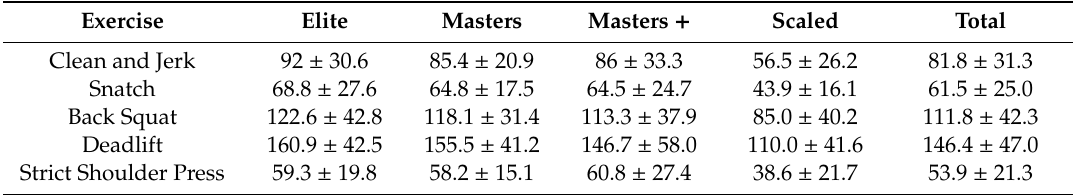
Table 1. One-repetition maximum of the survey participants for di ff erent CrossFit exercises as a function of competition